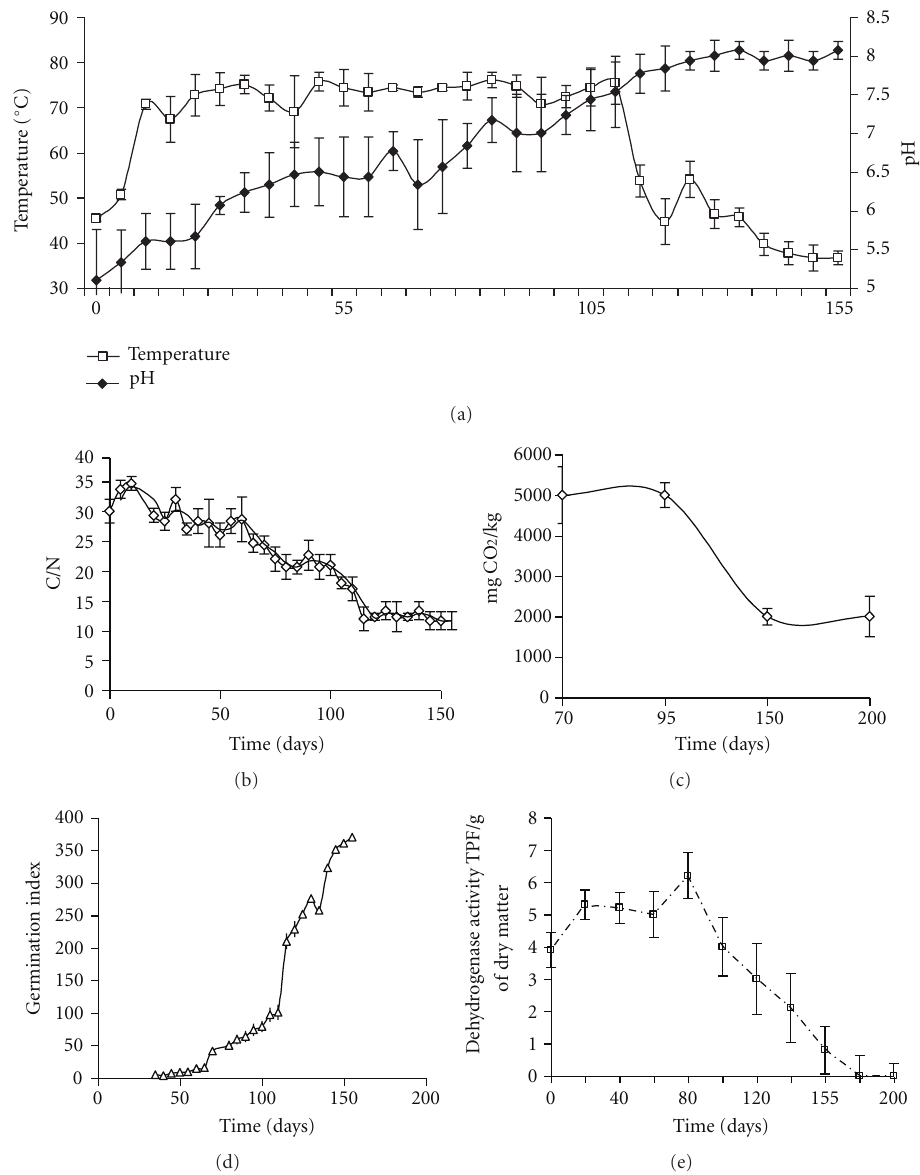
Figure 1: Trends of biochemical and microbiological parameters during composting cycle of mixed vegetable waste (70%) and dead P. oceanica (30%) (vol;